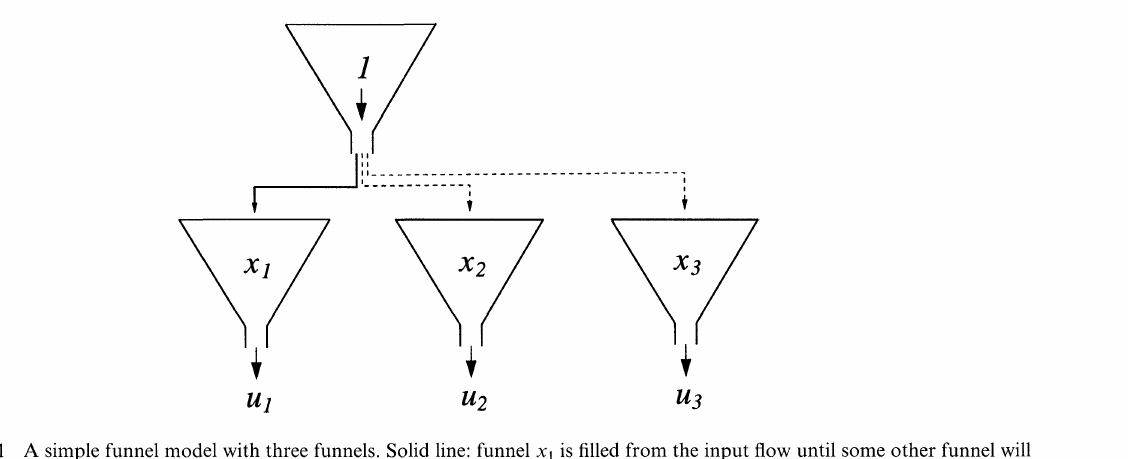
A simple funnel model with three funnels. Solid line: funnel x is filled from the input flow until some other funnel will be empty. Dashed lines illustrate the other two posible cases, when funnel x2 or x3 is being